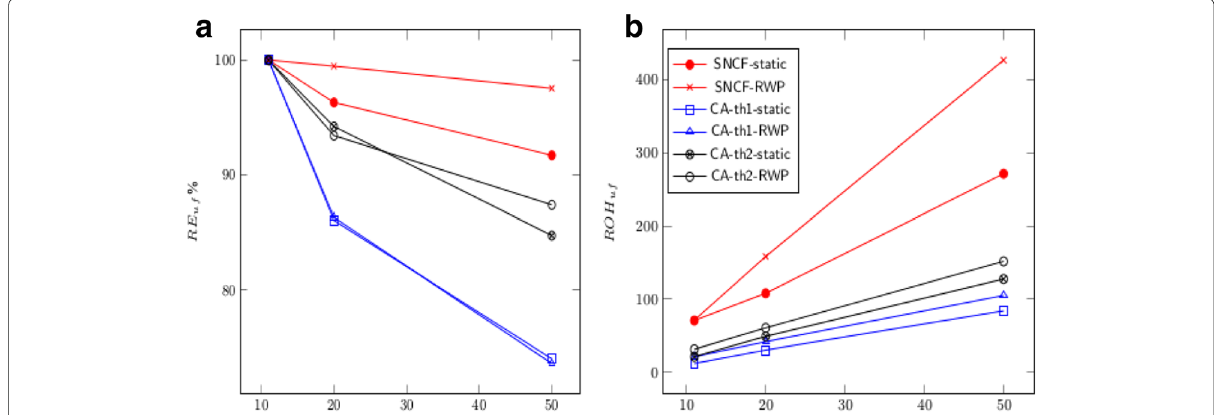
Fig. 27 Redundancy overhead and reachability of endcast until the destination is reached for SNCF and CA protocols with mobility when the threshold of CA protocol is set at 1 and 2 ( th1 and th2 ). a Reachability. b